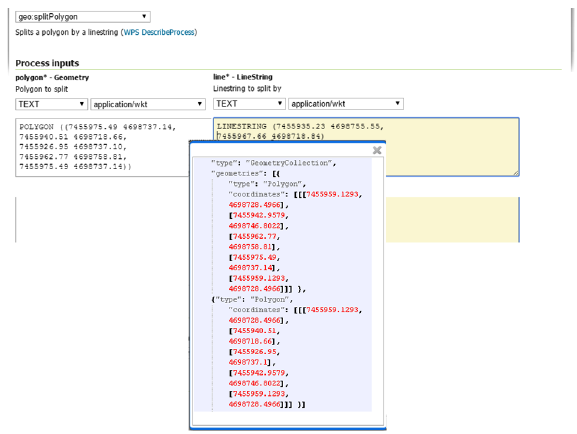
Figure 15. Polygon splitting with a line through WPS service